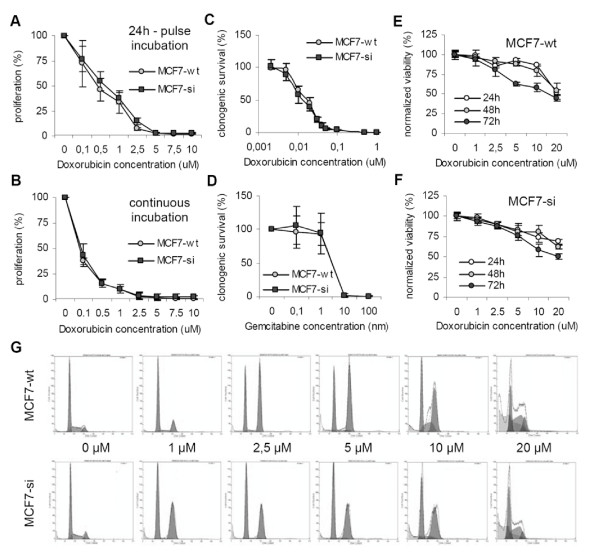
Evaluation of the chemosensitivity of wild type and PP2Cα siRNA-expressing MCF7 cells. A and B: Effect of different doses of doxorubicin on the proliferation of MCF7-wt and MCF7-si cells. The cells were either exposed to the drug for 24 h (A) or continuously (B). Values represent average ± SD (n = 3). C: Effect of doxorubicin on the clonogenicity of MCF7-wt and MCF7-si cells. Values represent average ± SD (n = 3). D: Effect of gemcitabine on the clonogenicity of MCF7-wt and MCF7-si cells. Values represent average ± SD (n = 3). E and F: Quantification of the effect of doxorubicin on the viability (i.e. the membrane integrity) of MCF7-wt and MCF7-si cells. The viability was determined by means of FACS analysis. Values represent average ± SD (n = 3). G: Representative images of the cell cycle distribution of MCF7-wt and MCF7-si cells after 48 h of doxorubicin treatment.